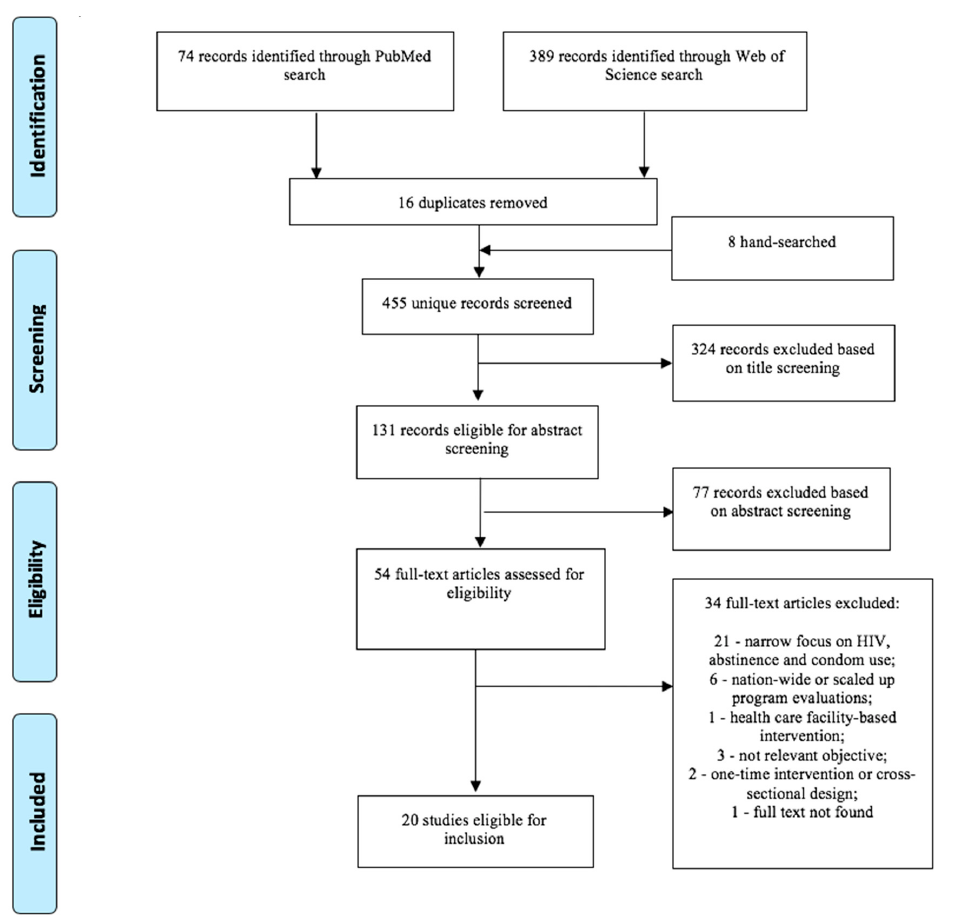
Figure 1. Preferred Reporting Items for Systematic Reviews and Meta-Analyses (PRISMA) flow.